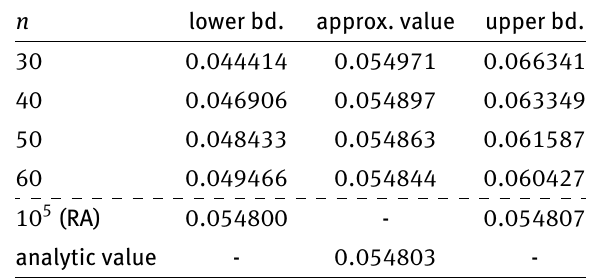
Table 1: Approximation results for Λ 3 . The values for n = 30, . . . , 60 were calculated by the method proposed in this paper, whereas the values for n = 10 5 were calculated using the rearrangement algorithm [16]. n lower bd. approx. value upper bd.